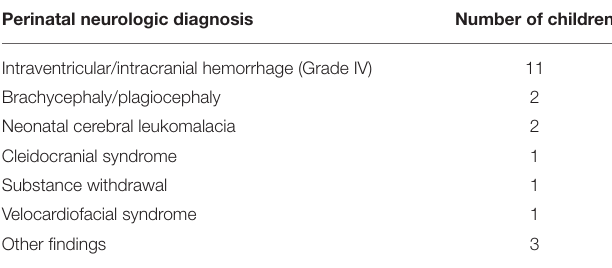
TABLE 1 | Perinatal neurological diagnoses in study cohort.